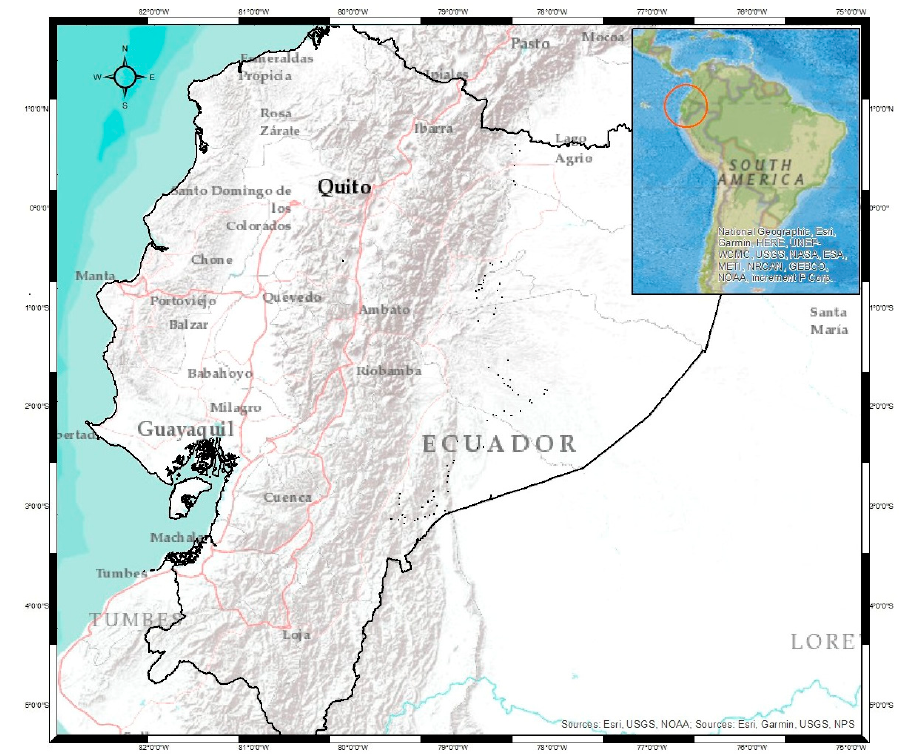
Figure 1. The study area (Ecuador) is localized on South America’s west coast, making it part of the so-called Pacific ring of fire. The relief is characterized by the presence of the Andes Mountain range that crosses from north to south, which generates an important source of earthquakes due to the overpressure of the magmatic fluids of the volcanoes present in this mountain range. These characteristics make Ecuador a territory with high levels of geoactivity.